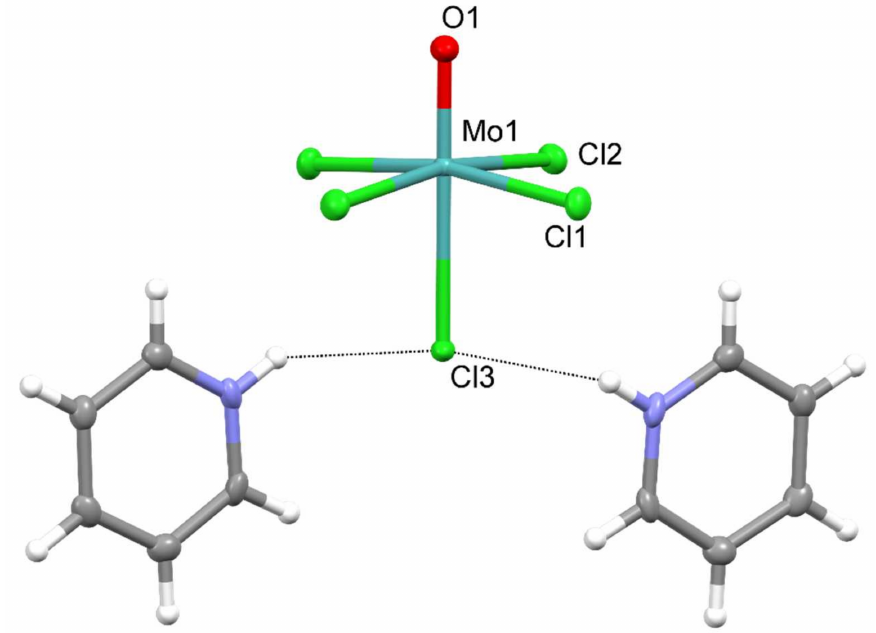
Figure 1. Displacement ellipsoids plot of formula unit in (PyH) 2 [MoOCl 5 ]. The ellipsoids are drawn at a 50% probability level, whereas hydrogen atoms are drawn as spheres of arbitrary radii. Dotted lines are the N–H ··· Cl